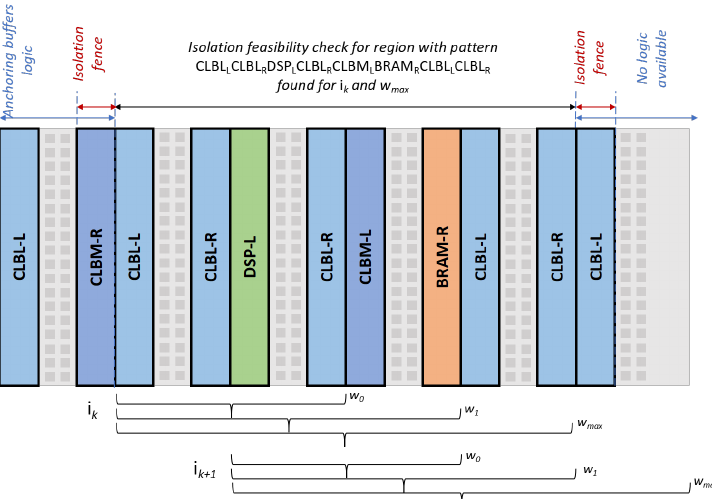
Figure 8. Example of iterative region search—required resource columns: BRAM, DSP, 2 × logic. If partition ports are located on right or both sides only regions (i k ; i k + w 1 ) and (i k +1 ; i k +1 + w 0 ) can be accepted. (Region (i k ; i k + w 0 ) does not satisfy resource requirements—no BRAM. Other regions can only use ports to the left as no logic for anchoring buffers is available to the